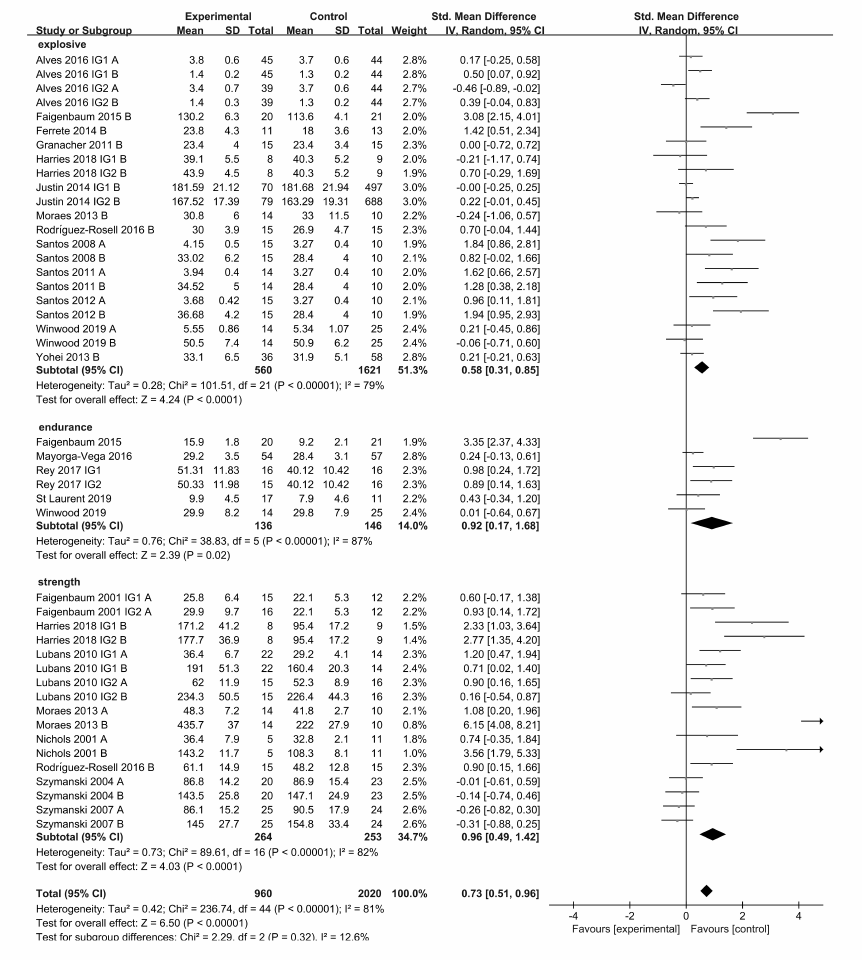
Figure 2. Effects of physical activity on muscle fitness. IG1: intervention group 1; IG2: intervention group 2; A: upper limb; B: lower